Question: Which visualization type does this figure use?
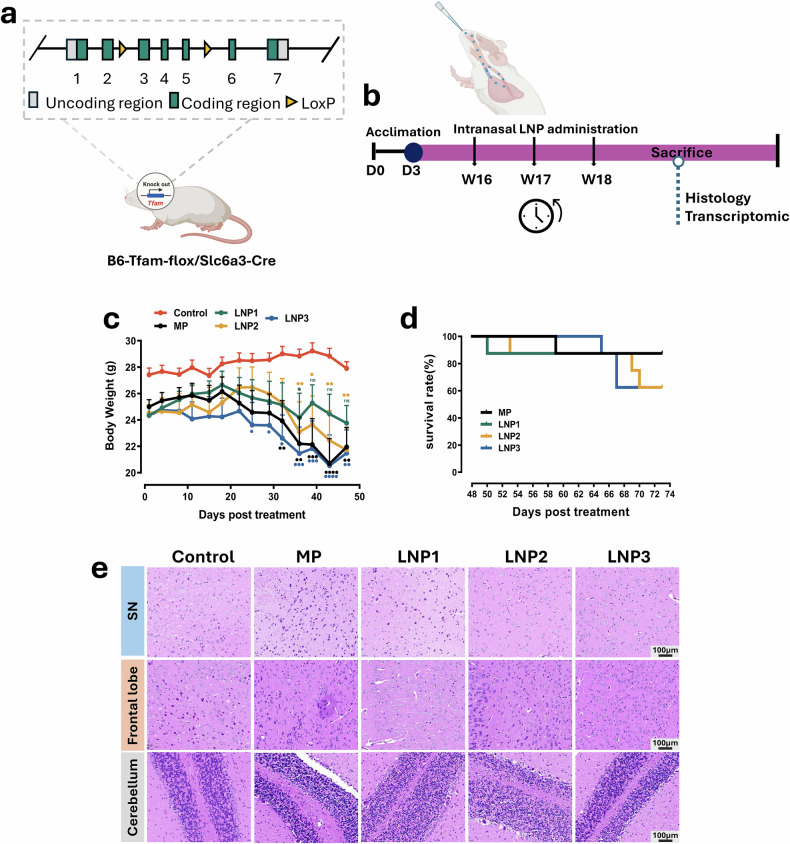
Answer: survival